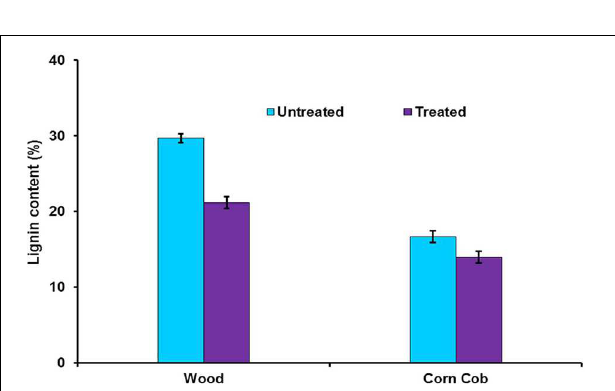
FIGURE 10 | Enzymatic delignification of wood and corncob using crude LccH. The substrates were treated with crude LccH (50 µ .g − 1 of biomass) for 17 h under shaking